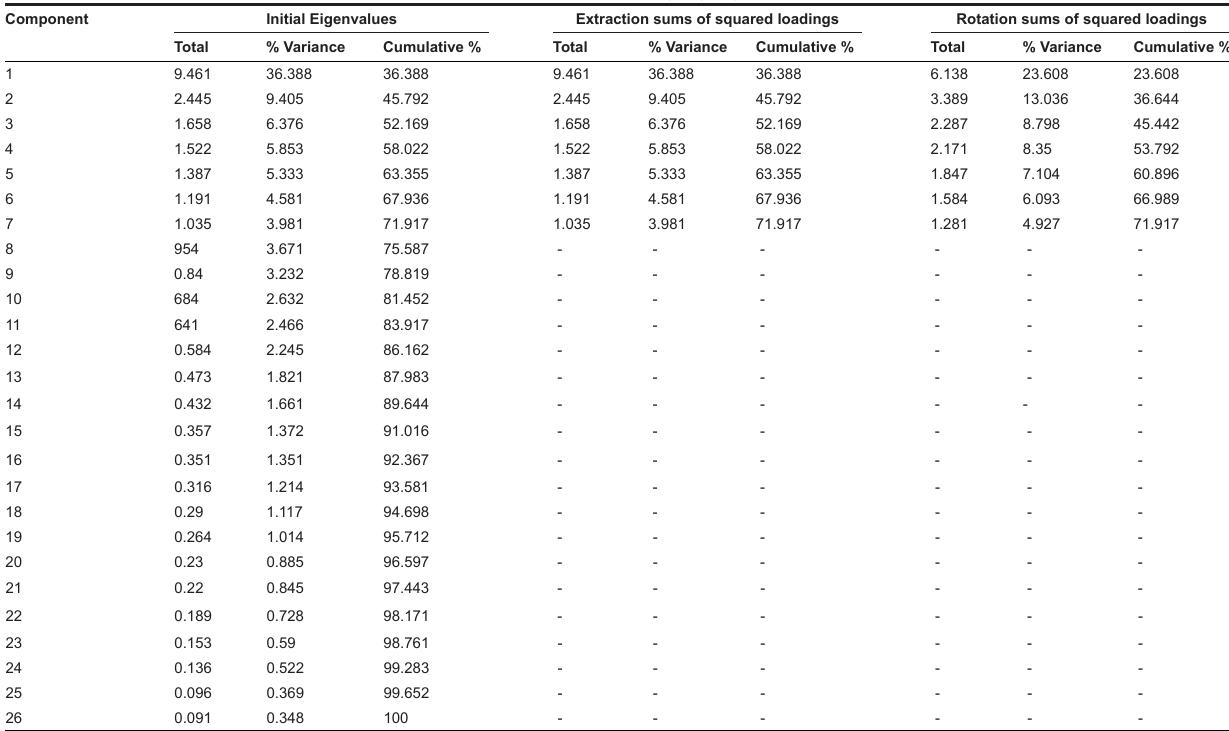
Table 3 Principal component analysis